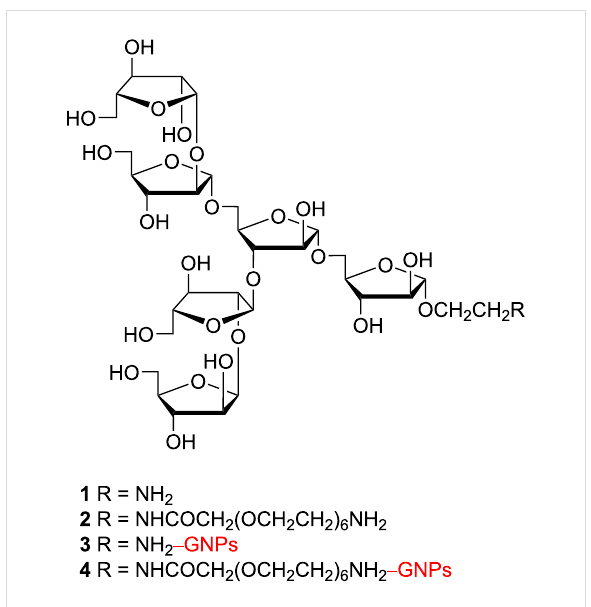
Figure 1: Structures of the hexasaccharide fragments of LAM/AG with amino groups at the terminal position of short ( С 2 ) or elongated ( С 2 ( Е G) 7 ) spacer aglycons (Ara 6 glycosides 1 and 2 , respectively) and their conjugates with gold nanoparticles (GNPs) (Ara 6 -GNPs 3 and 4 ,